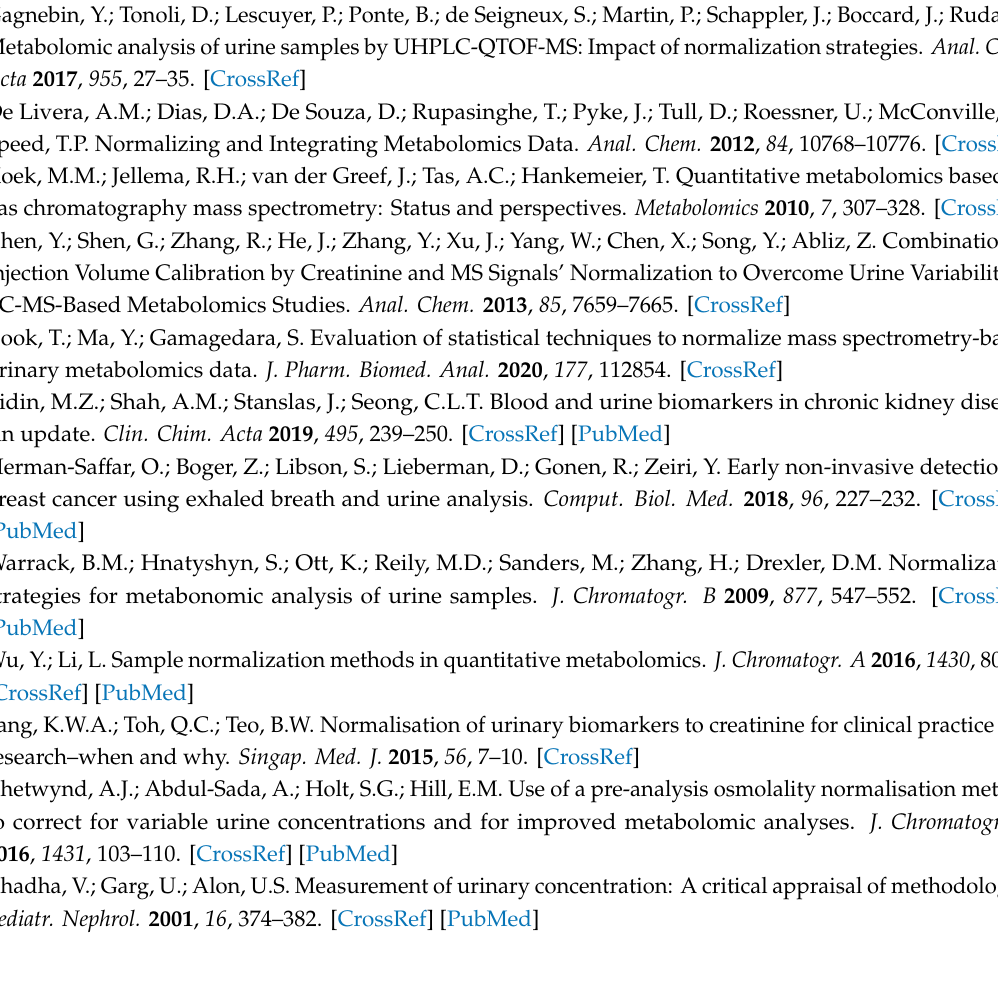
Figure S1: PCA score plots for di ff erent normalization methods before applying any feature selection. Each dataset was 54 samples × 5572